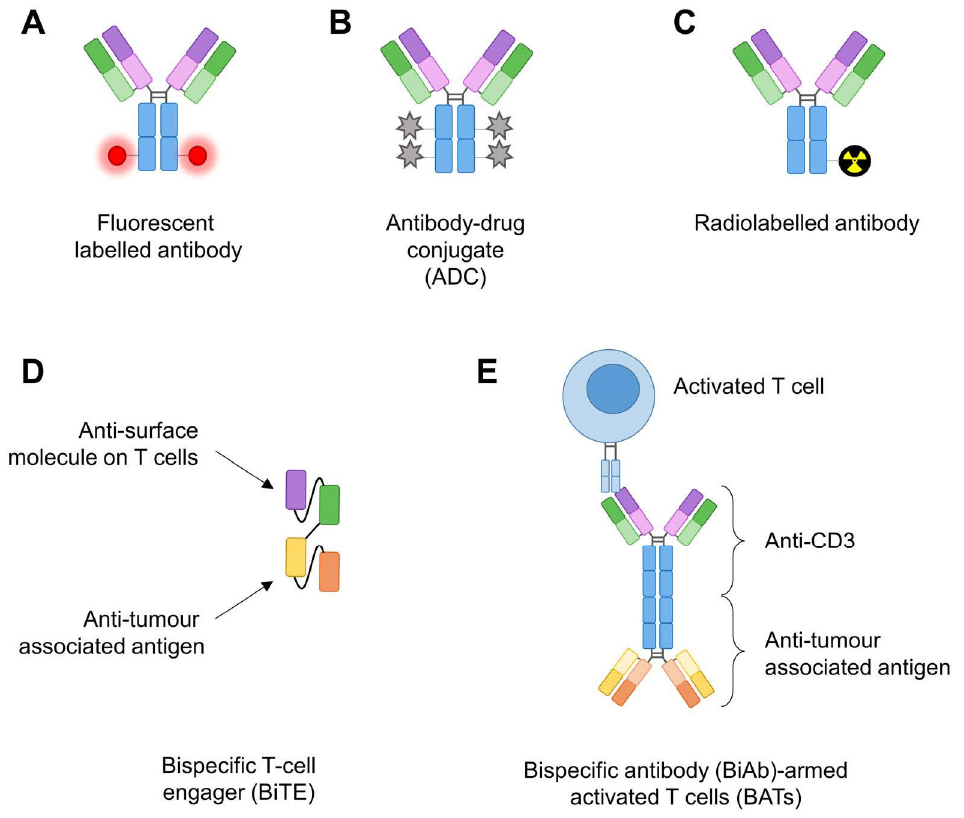
Figure 2. Antibodies’ functionalisation for cancer therapy. ( A ) Fluorescent labelled antibody: a fluorescent dye (usually far-red) is linked to an antibody. ( B ) Antibody-drug conjugate (ADC) is an antibody modified with cytotoxic drugs. ( C ) Radiolabelled antibody is linked to a radioisotope moiety for targeted radionuclid therapy and/or imaging. ( D ) Bispecific T cell engager (BiTE) is usually two scFvs linked together: one binding a tumour-associated antigen (TAA) and the other one a surface molecule on T cells. ( E ) Bispecific antibody-armed activated T cells (BATs) correspond to two full-length IgGs crosslinked and incubated with autologous activated T cells (i.e., from patients), and the BATs are reinfused back into the patients.